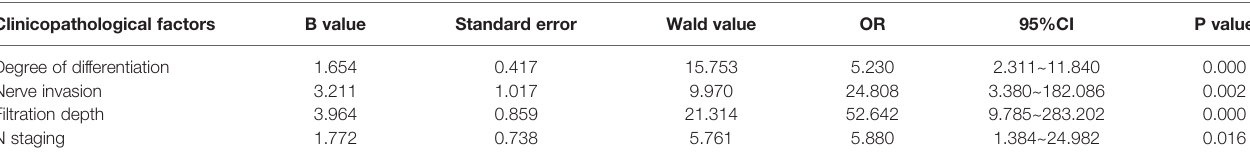
TABLE 2 | Multivariate prognostic analysis of 168 patients with gallbladder cancer.